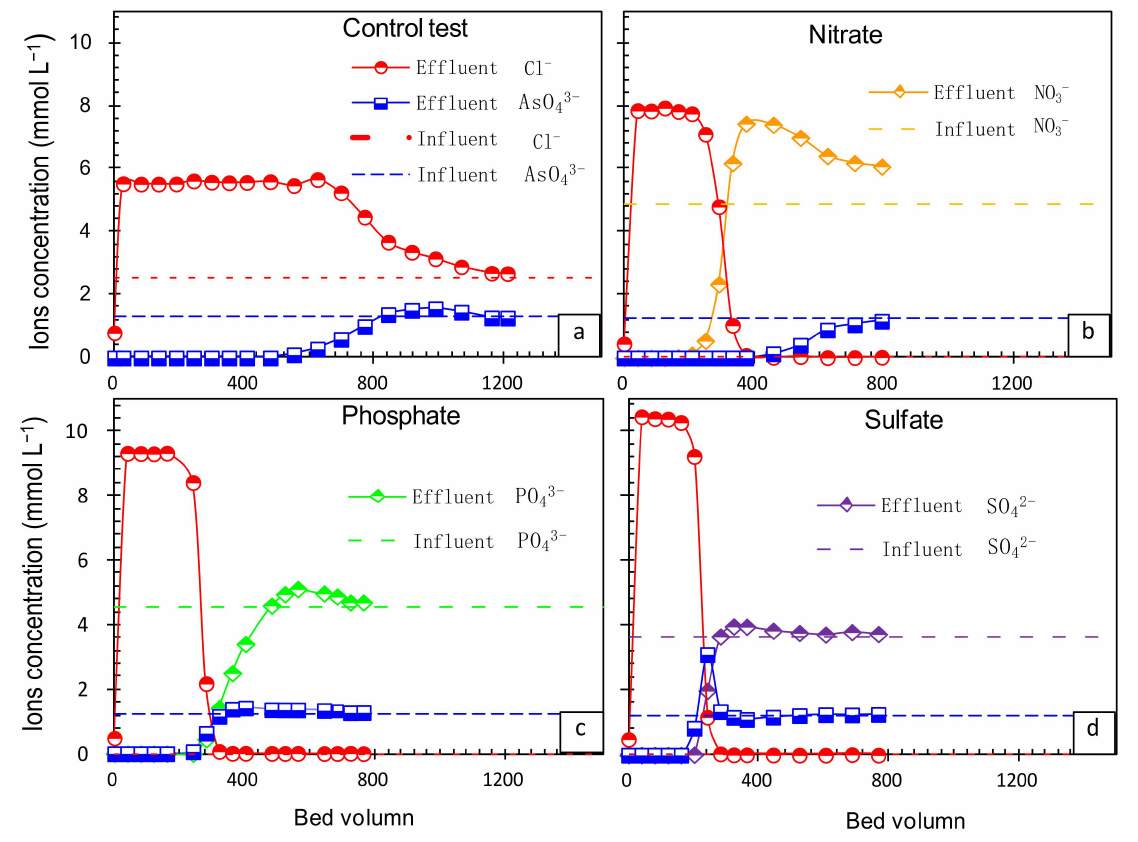
Figure 6. Effect of competing anions (control test ( a ), nitrate ( b ), phosphate ( c ) and sulfate ( d )) on the arsenate removal by FFA-1 fiber in continuous column